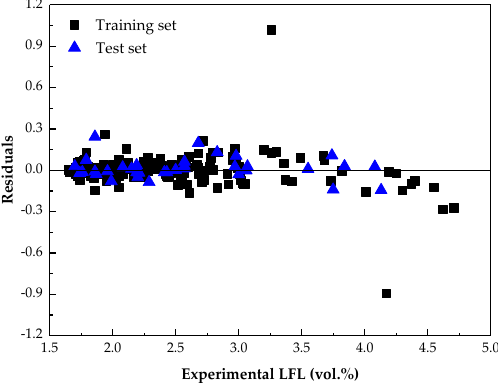
Figure 4. Plot of the residuals vs. the experimental LFL values for the best model.